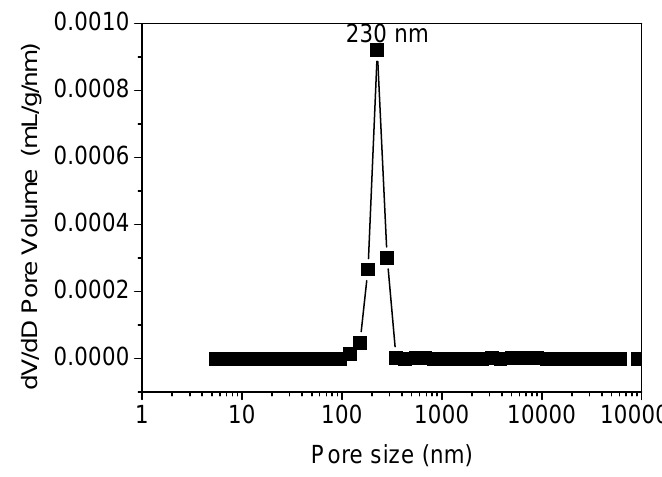
Figure 6. Mercury intrusion porosimetry result of the Al 2 O 3 ‐ YSZ membrane sintered at 1440 °C.